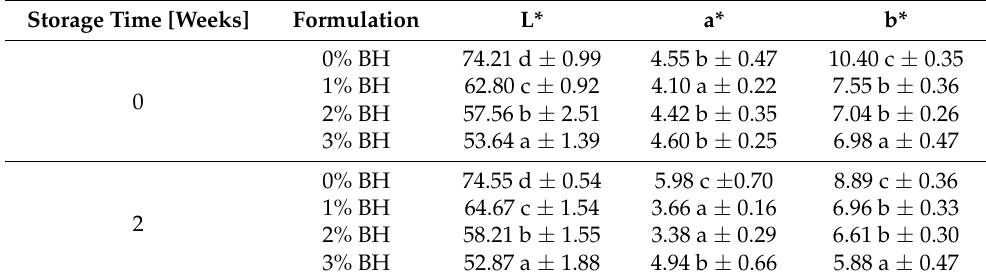
Table 4. Effect of BH on color parameters of